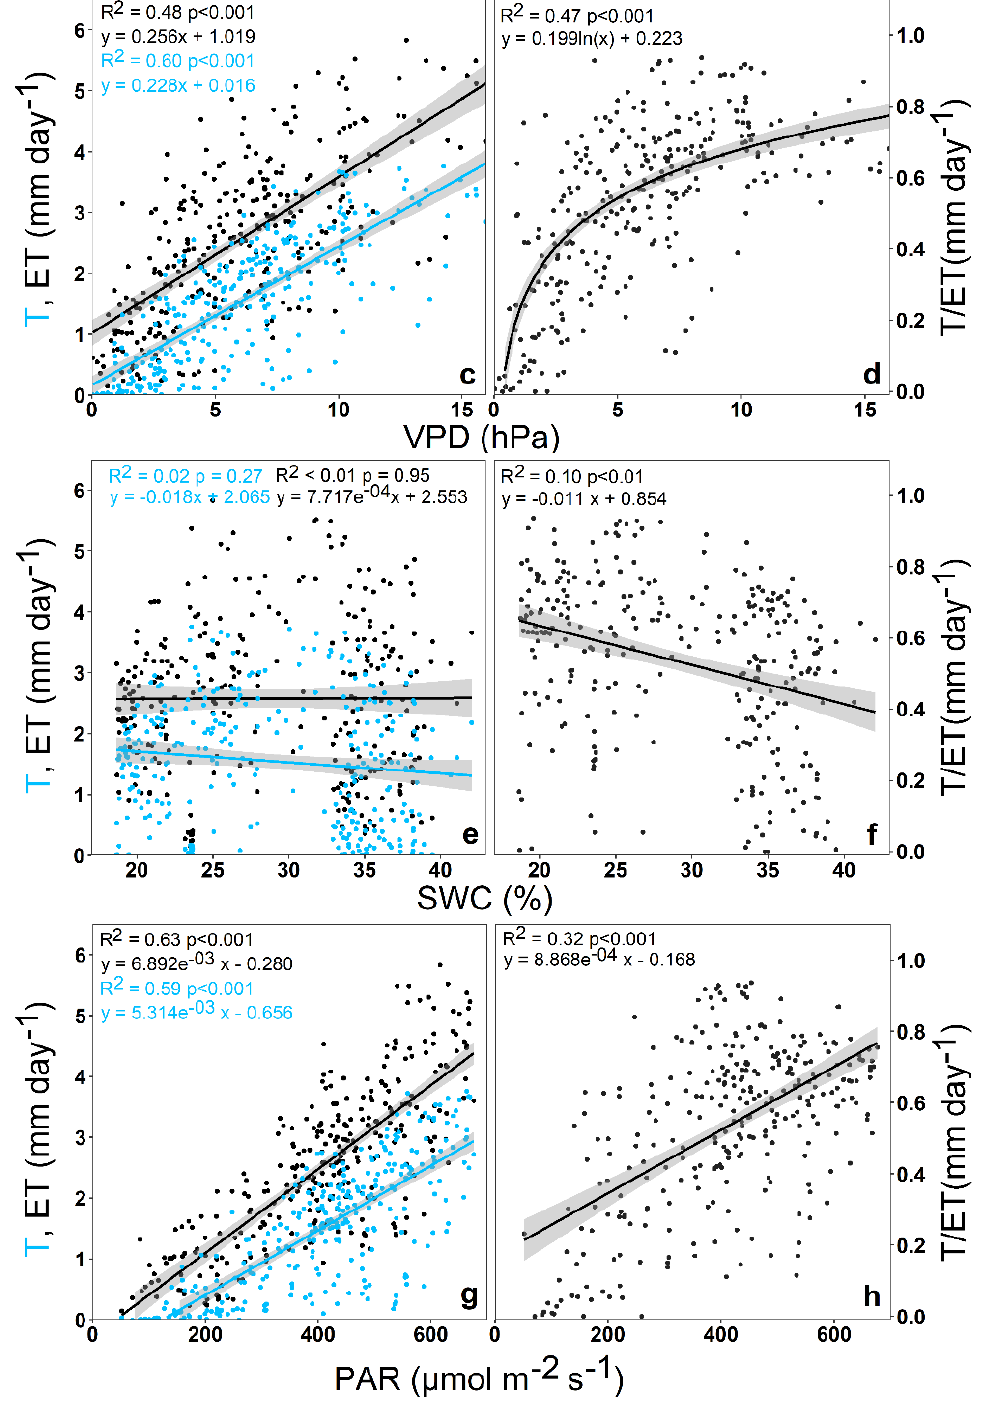
Figure 5. Impact of daily mean air temperature ( a , b ), vapour pressure deficit ( c , d ), soil water content ( e , f ) and photosynthetic active radiation ( g , h ) on daily sums of ecosystem transpiration, evapotran- spiration, and transpiration/evapotranspiration ratio during the 2019–2020 (April–October) period.